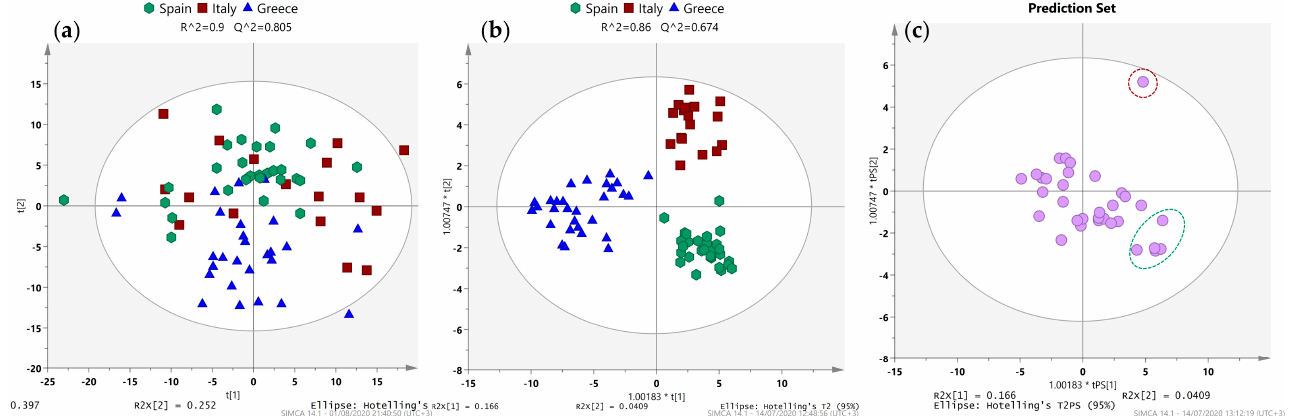
Figure 1. ( a ) PCA scores scatter plot of PC1 and PC2 with the European samples examining geo- graphical origin; ( b ) OPLS-DA scores scatter plot depicting the separation between Spain, Italy, and Greece; ( c ) scores scatter plot of all blended samples as the prediction set. One sample appears to contain mainly Italian EVOOs, five mainly Spanish, and the rest lie among the three countries.